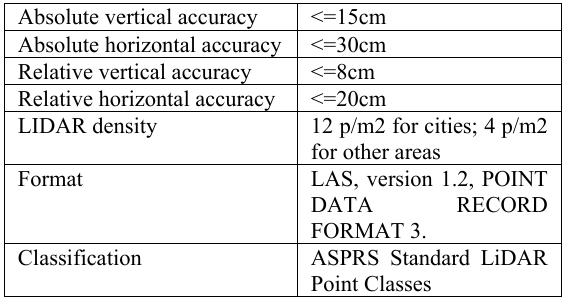
Table 3. LIDAR data- parameters of